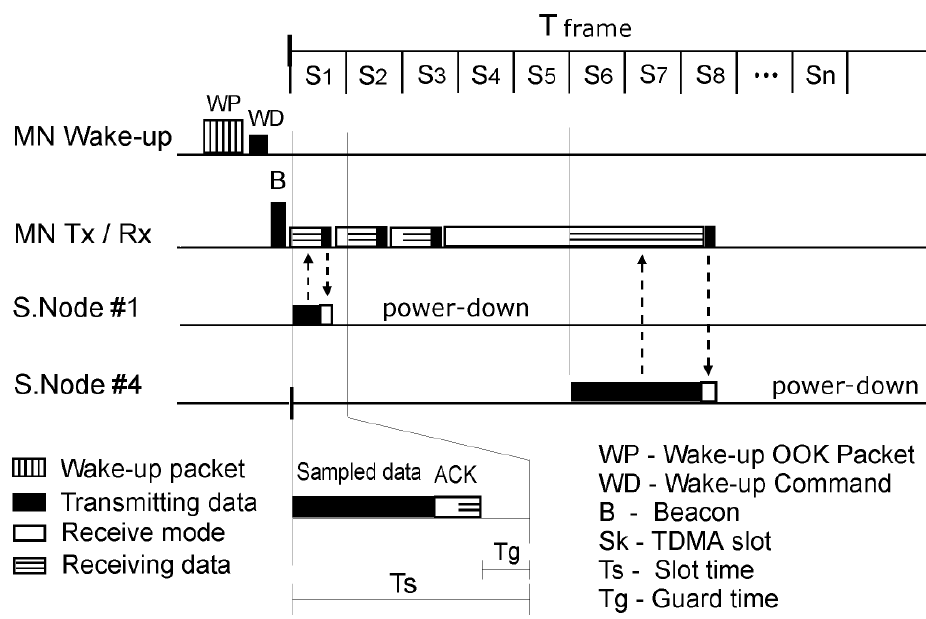
Figure 4. whMAC TDMA frame.